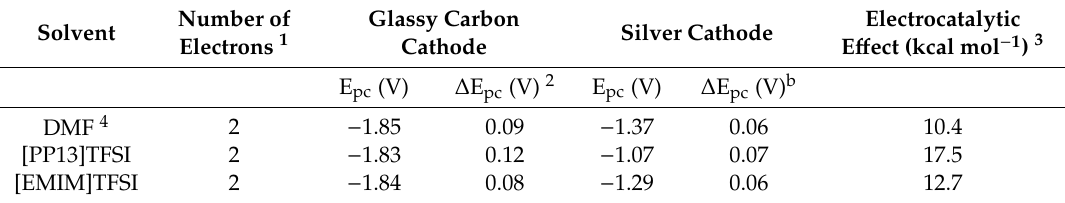
Table 1. Electrochemical parameters for the electrochemical reduction of 1 .